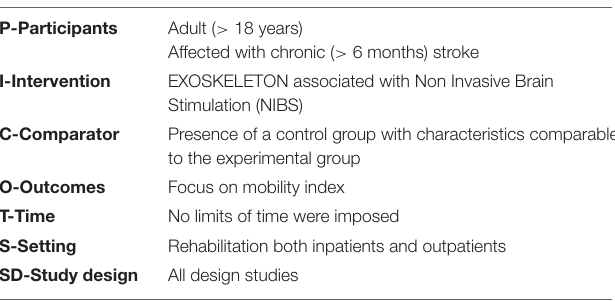
Frontiers in Neurology |